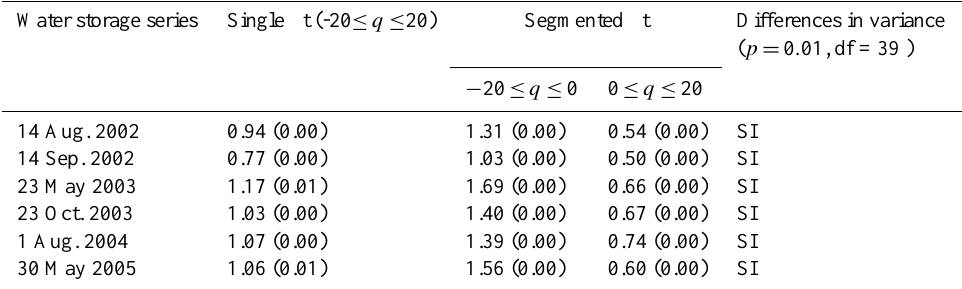
Table 3. Slope of the mass exponent functions τ (q) of the water storage series and their standard